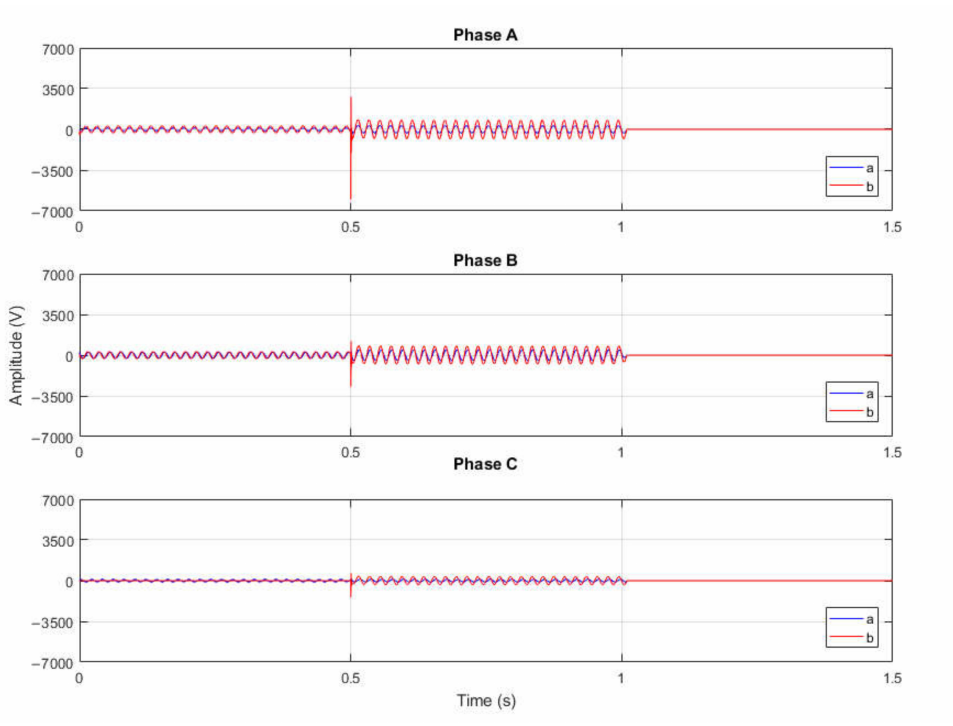
Figure 3. Voltage waveforms in the three-phase cable line screens in Terminal I.